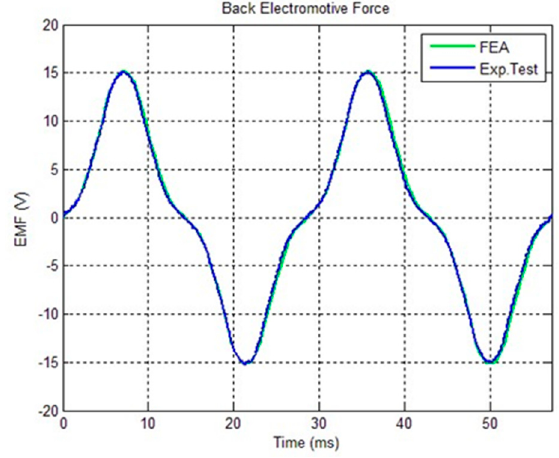
Figure 12. EMF waveform comparison between 3D FE analysis and experimental test.